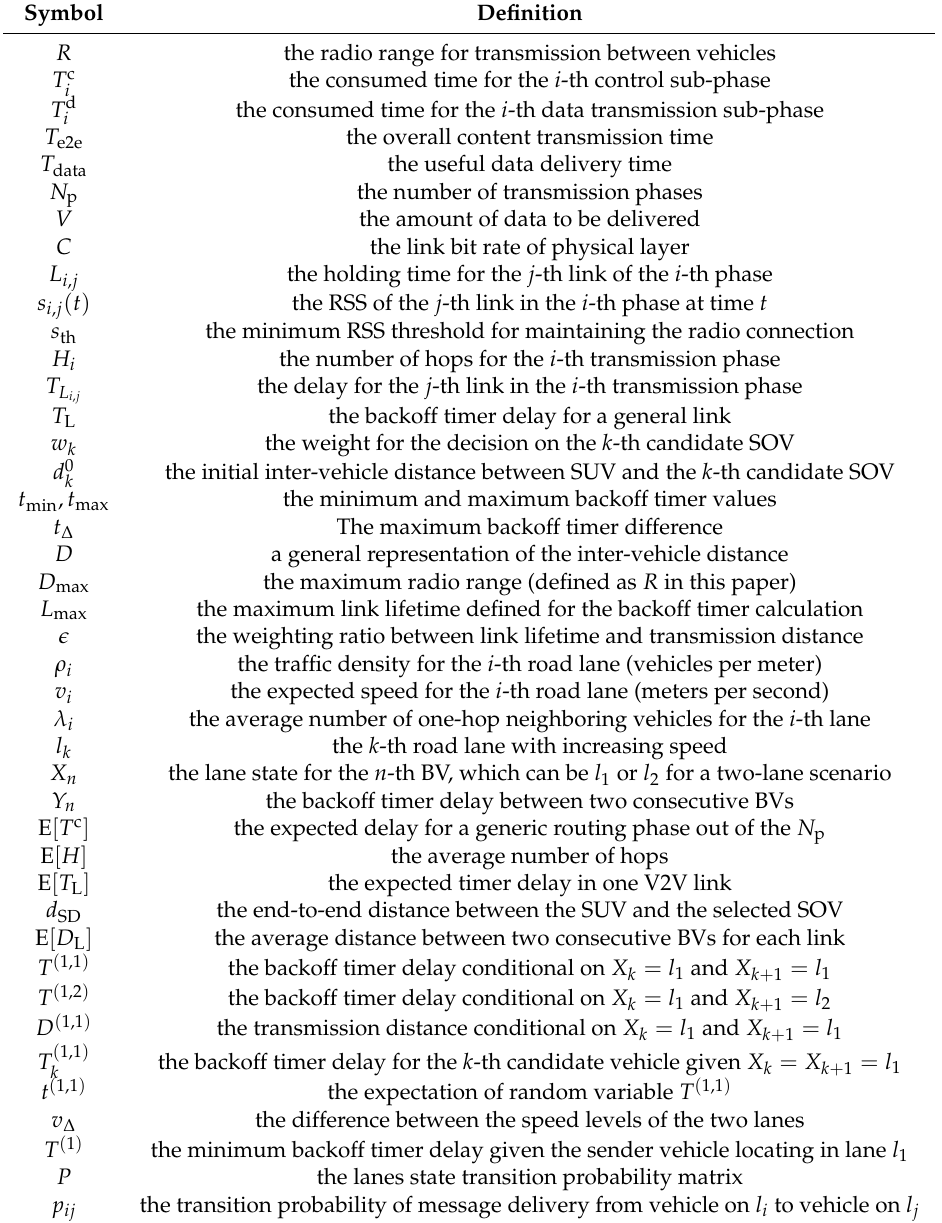
Table 1. Symbols definitions. SOV, SOurce Vehicle; SUV, SUbscribing Vehicle; BV, Backbone